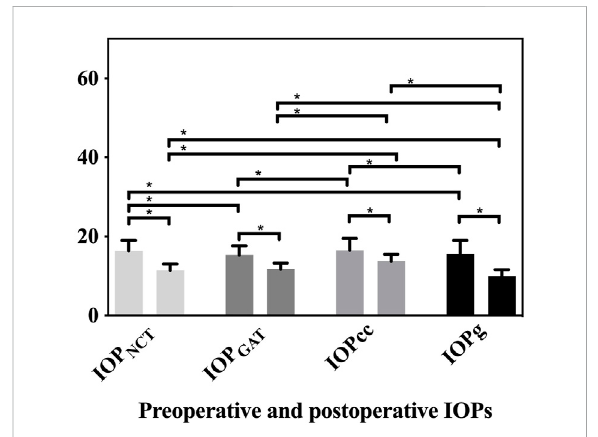
FIGURE 1 Preoperative and postoperative values of IOP NCT , IOP GAT , IOPg, and IOPcc. Signi fi cant decreases in all IOPs were detected compared to preoperative values (all p < 0.001). Except for IOP NCT and IOPcc ( p = 0.631) and IOP GAT and IOPg ( p = 0.382), all other preoperative IOPs differed from each other (all p < 0.05) (IOP NCT andIOP GAT p =0.005, IOP NCT andIOPg p =0.049, IOP GAT and IOPcc p = 0.001, and IOPcc and IOPg p = 0.015). After the surgery, except for IOP NCT and IOP GAT ( p = 0.095), each postoperative IOP was different from other the three IOPs (all p < 0.001).